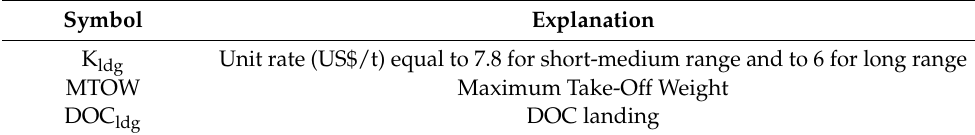
Table 5. Landing cost symbols explanation.